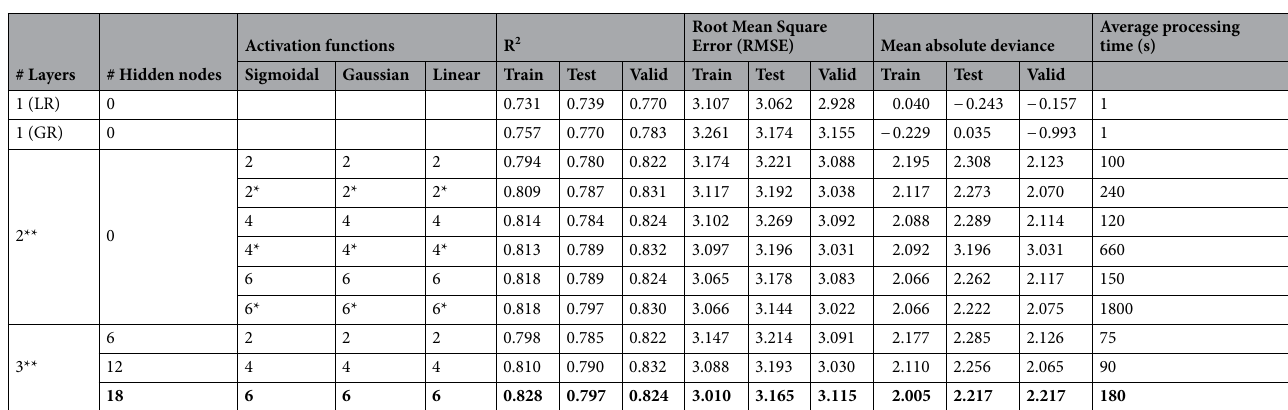
Table 3. Comparison of the Linear Regression (LR) using Standard Least Squares method, Generalized Regression (GR) model using a logarithmic transformation and the double-lasso method, and the main ablation experiments of the Artificial Neural Network (ANN) methods tried. The ablation study identified the 2 hidden-layer ANN design (i.e., each layer with three sigmodal, three linear and three Gaussian activation functions) as the best compromise between improved performance and processing speed (bold characters). *Using an additive sequence of 100 models based on a learning rate of 0.1. **Using for optimization a robust fit with a squared penalty method and transformed